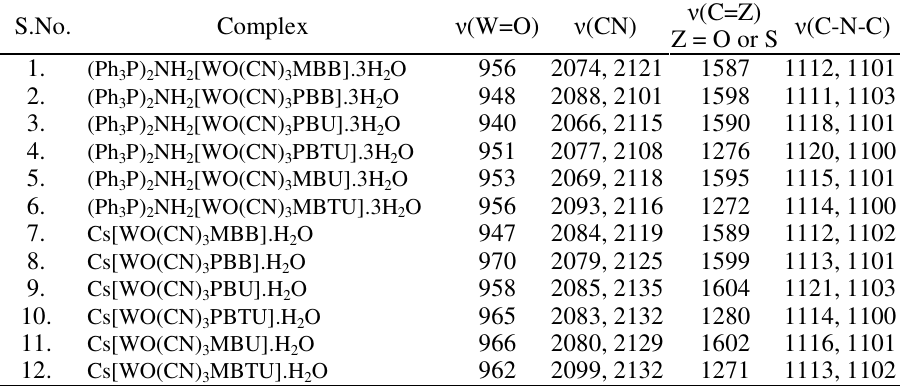
Table 1. Analytical data and some physical properties of oxotungsten(IV) complexes o . Complex N (Mol. Wt.) S .